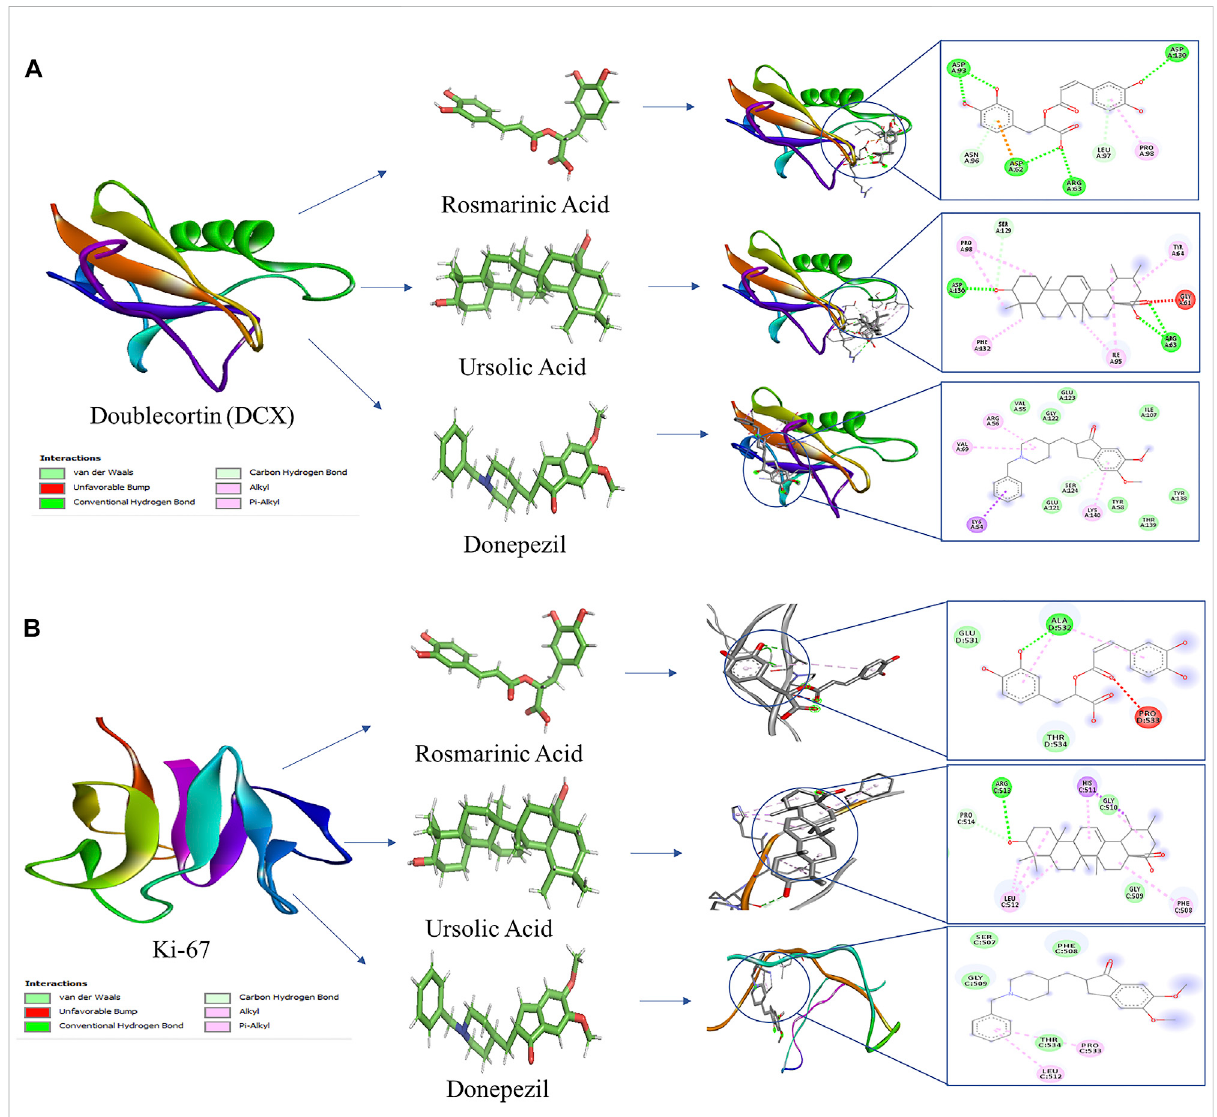
FIGURE 6 Molecular docking interaction models of RA, UA, and donepezil with DCX and Ki-67. 2D structures of the compounds are shown by line and stick models with the surrounding amino acids of (A) DCX and (B) Ki-67. The interactions are denoted by the following colors: hydrogen bonding interactions (green), alkyl bonds (pink) and bumps